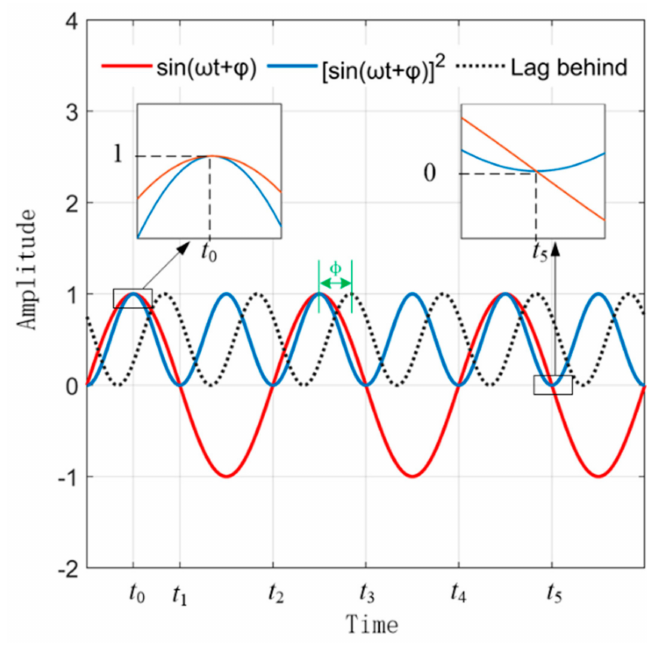
Figure 11. sin( ω t+ ϕ ) and [sin( ω t+ ϕ )] 2